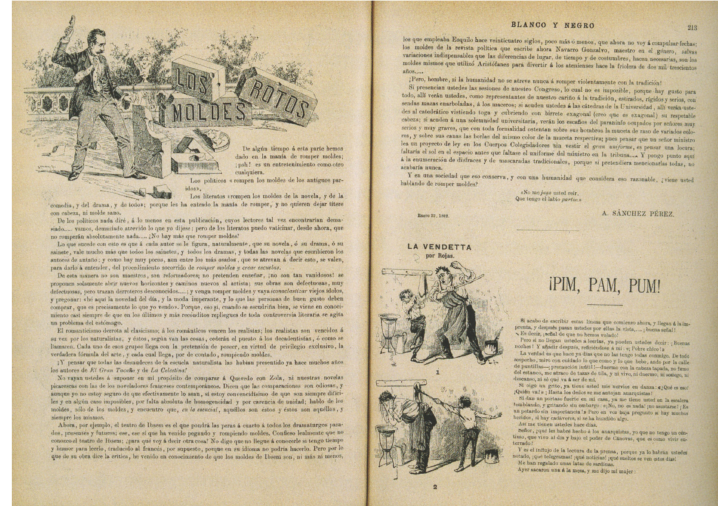
Figure 1. Blanco y Negro , 48. Madrid, 3 April 1892.